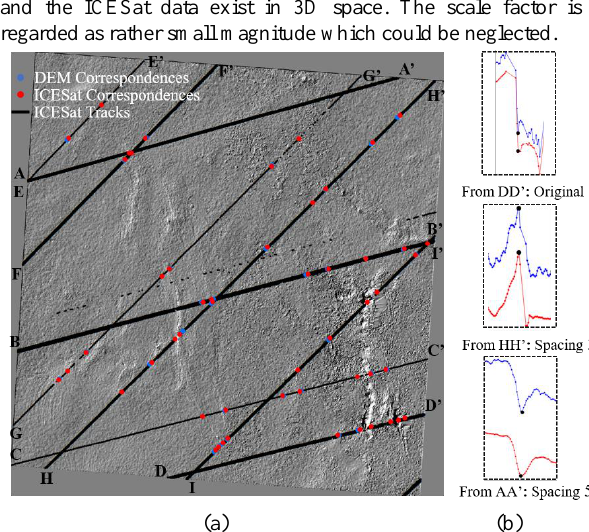
Figure 4. ICESat tracks and selected correspondences. (a) The background image is a shaded relief map derived from the ASTER DEM with sun azimuth of 124° and sun elevation of 27.9°. Blue and red points are correspondences selected from ICESat and DEM profiles. (b) Three strategies of correspondence selection for different terrain features.